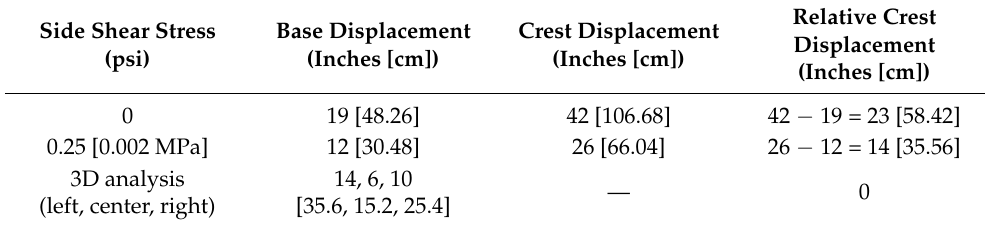
Table 9. 2D Study Case 3, estimated permanent displacements for the MYG008-50k Earthquake using base case (one-year)